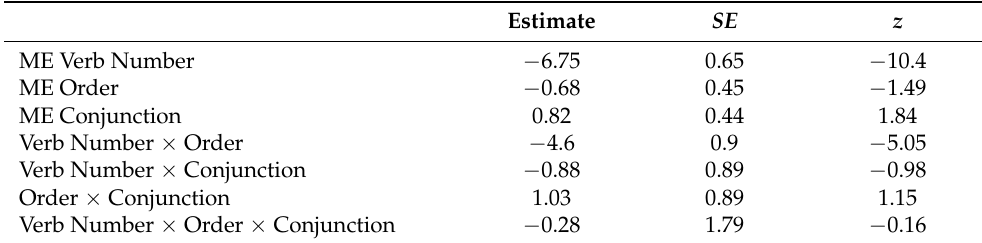
Table 13. Summary of the statistical analyses of participants’ end-of-sentence acceptability judge- ments, Experiment